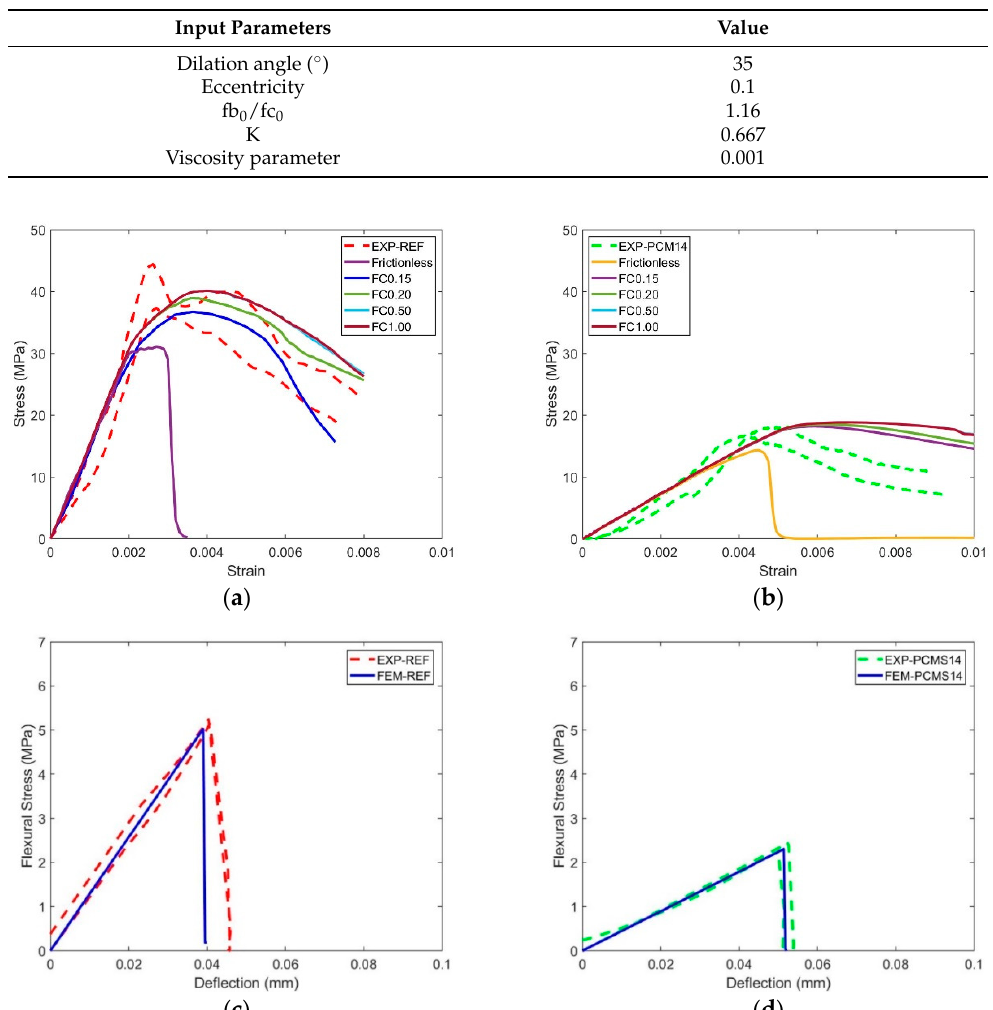
Table 7. Model input plasticity parameters.